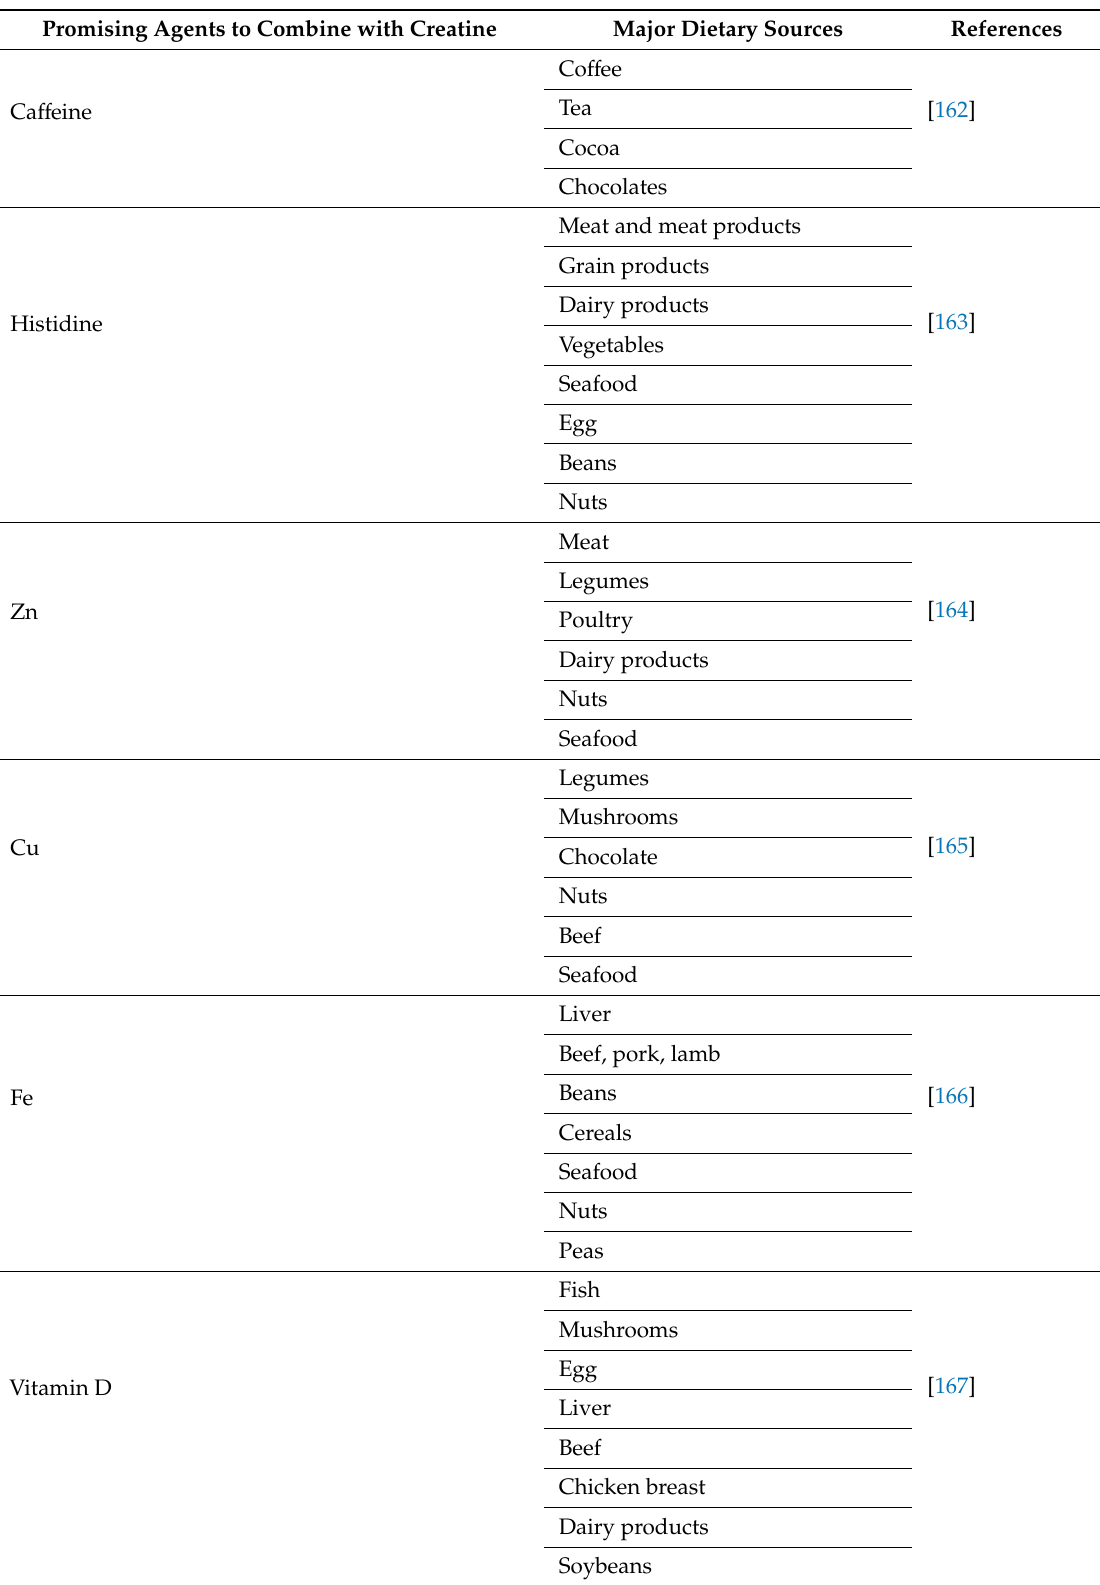
Table 4. Major dietary sources of ca ff eine, histidine, Zn, and vitamin D. Cu-chelators are not presented naturally in